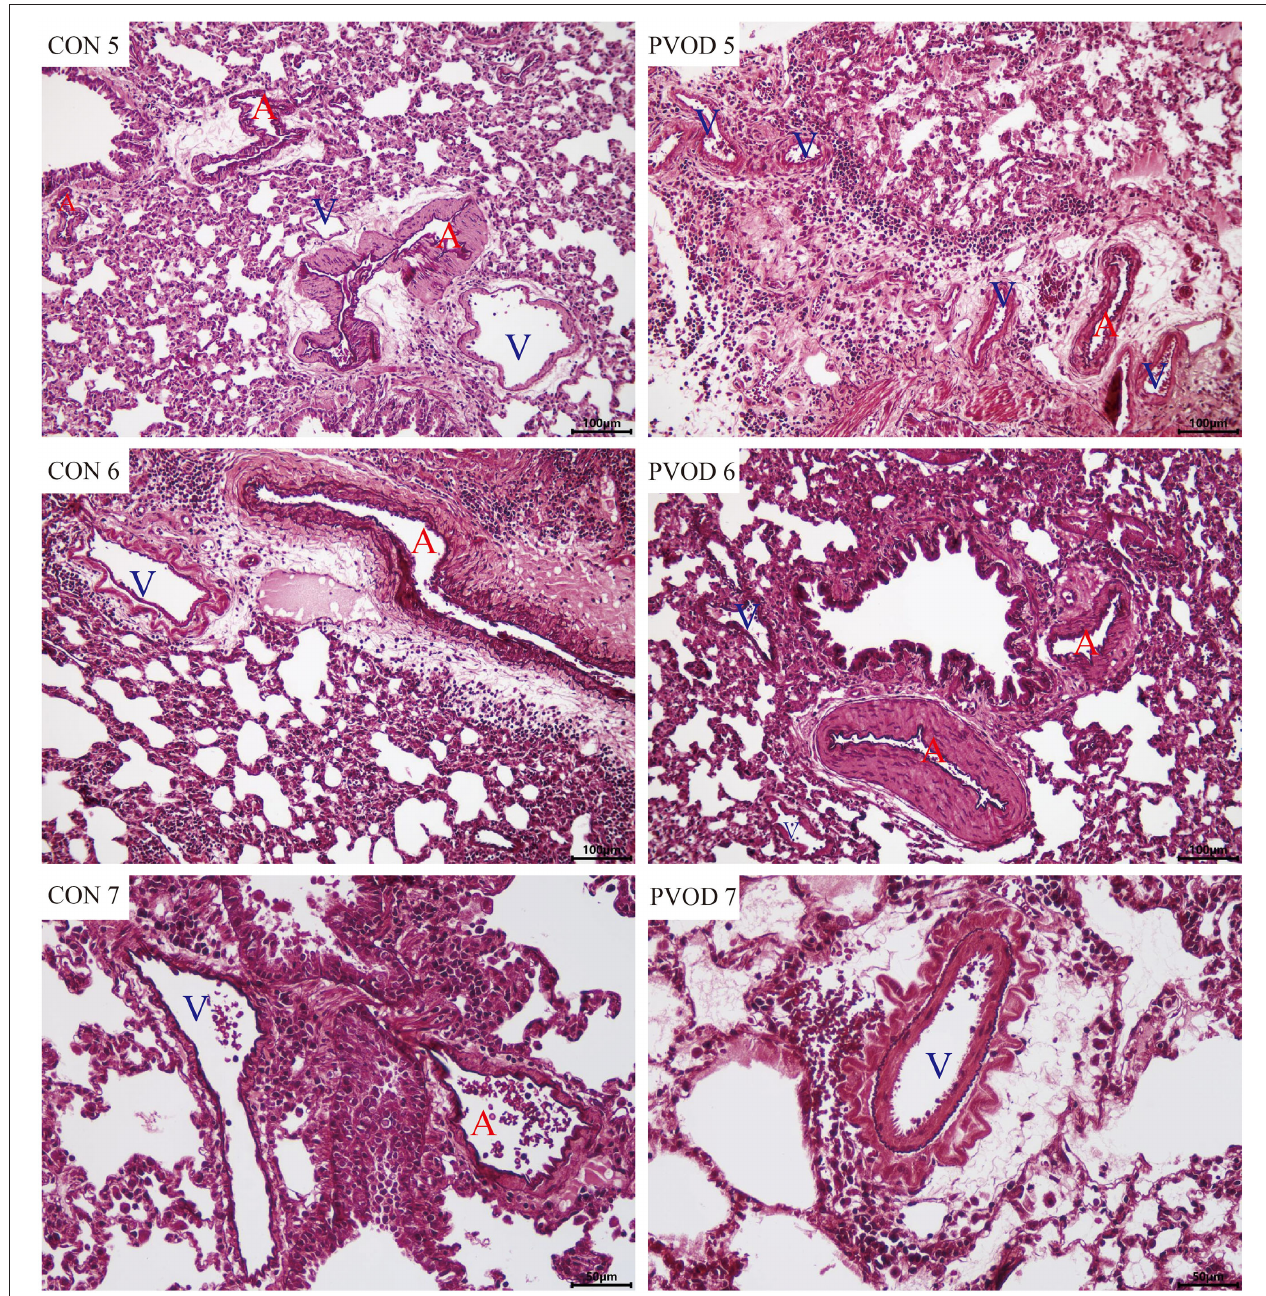
FIGURE 5 | The pulmonary vascular changes in control and MMC-induced rat with PVOD with orcein stained. The pulmonary artery with medial hypertrophy/hyperplasia, thickening, and occlusion in the small pulmonary veins were observed in PVOD group compared with control group. CON 5-7, control lungs; PVOD 5-7, MMC-induced lungs. CON 5-6 and PVOD 5-6: scale bar, 100 µ m; CON 7 and PVOD7: scale bar, 50 µ m. The control group ( n = 4 rats) and the PVOD group ( n = 10 rats). A, artery; V, vein; MMC, mitomycin-C; PVOD, pulmonary veno-occlusive